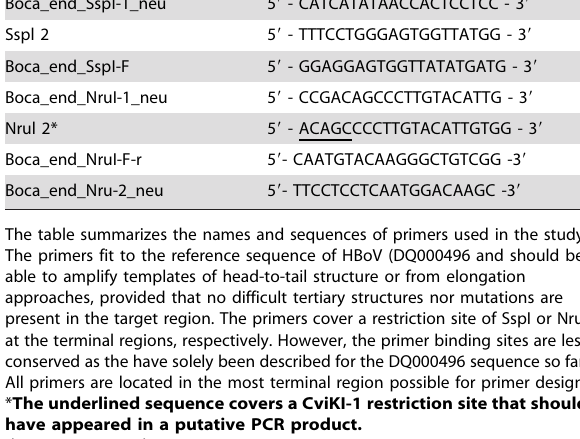
Figure 1. Approach for deciu¨phering the hairpin like structure of human bocavirus. a: Putativehairpinstructuresofhumanbocavirus. In order to test for the self priming capability of the HBoV genome during genome replication different polymerases were added to HBoV DNA isolated from clinical samples. Both, positive strand and negative strand containing isolates were used [23]. Following self-priming elongation the DNA was denaturized and PCR was performed with a single primer. Surprisingly in none of the tested isolates a PCR product was observed, leading to the conclusion that no self priming occurred. b: HBoVendterminusPCRwithprimerNrul1andSsp1,respectively. HBoV genome preparations were incubated with T7 polymerase and subject to subsequent PCR with primers Boca_end_NruI-1_neu and Boca_end_SspI-1_neu, respectively. Theoretically, elongation of terminal hairpin structures (self-priming) should have occurred as postulated in figure 1a. c: HBoVendterminusPCR withprimerNrul2andSsp2,respectively. HBoV genome preparations were incubated with Klenow polymerase and subject to subsequent PCR with primers NruI-2 and SspI-2, respectively. Theoretically, elongation of terminal hairpin structures (self-priming) should have occurred as postulated in figure 1a. d: HBoVendterminusPCRaftercircularisationofthegenomewithprimerNrul2andSsp2. HBoV genome preparations were incubated with T4 RNA ligase (self-ligation of single strand genomes and subject to subsequent PCR with primers Nru2 and Ssp2, respectively. Theoretically, head-to-tail sequences should have been amplified provided the terminal regions of the genome allow self-ligation and are not masked by secondary structures resistant to self-ligation. e: HBoVPCRwithprimersetBoca_end_SspI-1_neuandBoca_end_NruI-1_neu. This PCR approach was performed with primer in the outmost terminal region of the HBoV genome DQ000496. The PCR reaction should have amplified head-to-tail, tail-to- tail, or head-to-head structures, provided the target sequence is present in the clinical isolates. Unfortunately the primers did not bind to a terminal region that is know among all so far published isolates, thus it remains unclear whether primer binding was